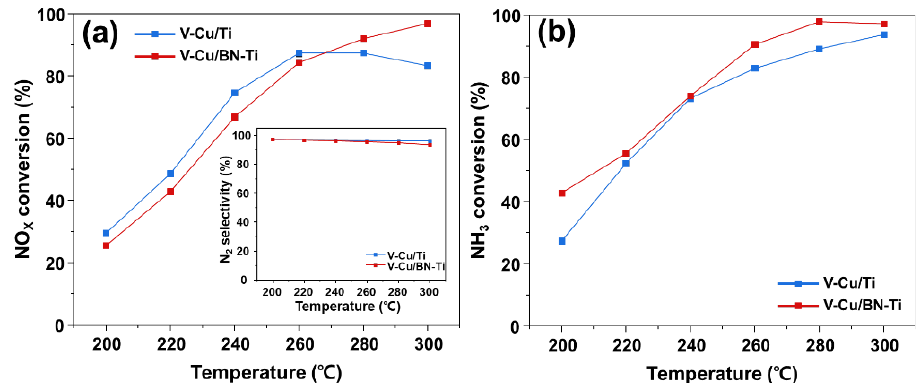
Figure 6. Slipped NH 3 oxidation performance during NH 3 conversion by the synthesized catalysts, calculated using Equation (11). NH 3 -SCR, orange bar; NH 3 -SCO, green bar; and NH 3 -Slip, purple bar. Gas conditions were [NO X ] = [NH 3 ] = 300 ppm, [O 2 ] = 5 vol. %, [N 2 ] = balance, total flow = 500 mL/min, and GHSV = 60,000 h − 1 .